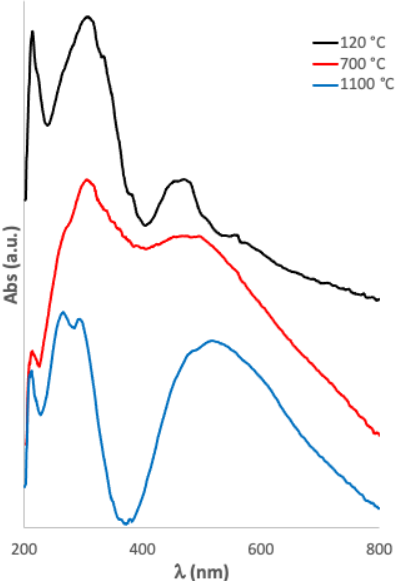
Figure 3. Uv-vis spectra of Mn-doped bioactive glass-ceramic as obtained at 120 °C (black line, above), after treatment at 700 °C (red line, middle), and at 1100 °C (blue line, below).